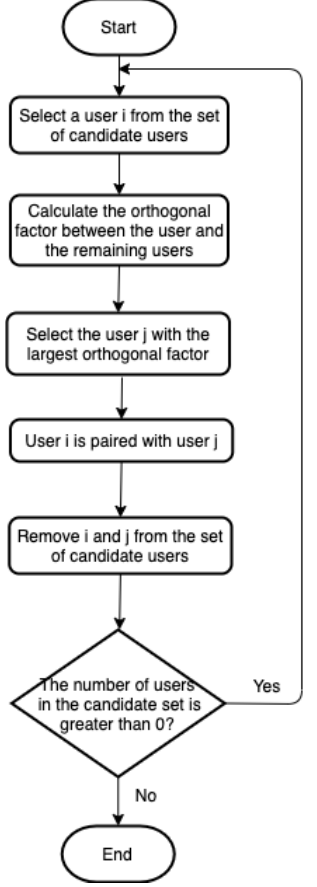
Figure 9. The flowchart of orthogonal pairing